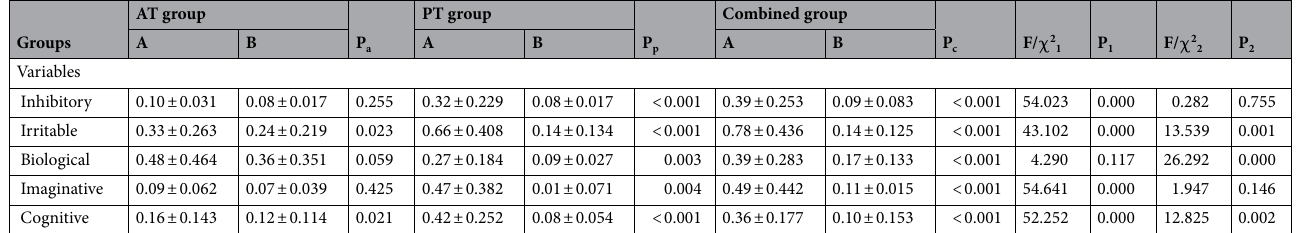
Table 2. The five factor-scores of SSCS among patients in different groups before and after treatment. A: baseline; B: after the treatment. AT group: antidiabetics treatment group; PT group: psychotropics treatment group. Combined group: combined treatment group. P 1 : Comparison among the three groups before the treatment. P 2 : Comparison among the three groups after the treatment. P a : Self-control comparison of PT group before and after the treatment. P p : Self-control comparison of AT group before and after the treatment. P c : Self-control comparison of combined group before and after the